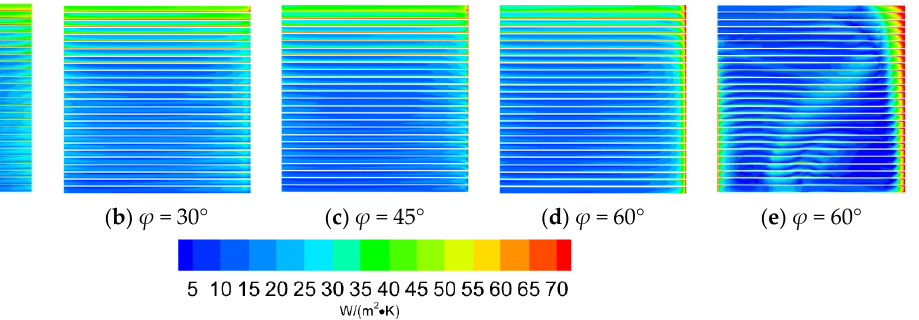
Figure 10. The change in CHTC avg of the louvers’ sun side with different wind directions ( U ref = 3.41 m/s, D = 0.05 H , B / H = 0.035, T H − T a = 10 °C, T B − T a = 20 °C, θ = 45°).